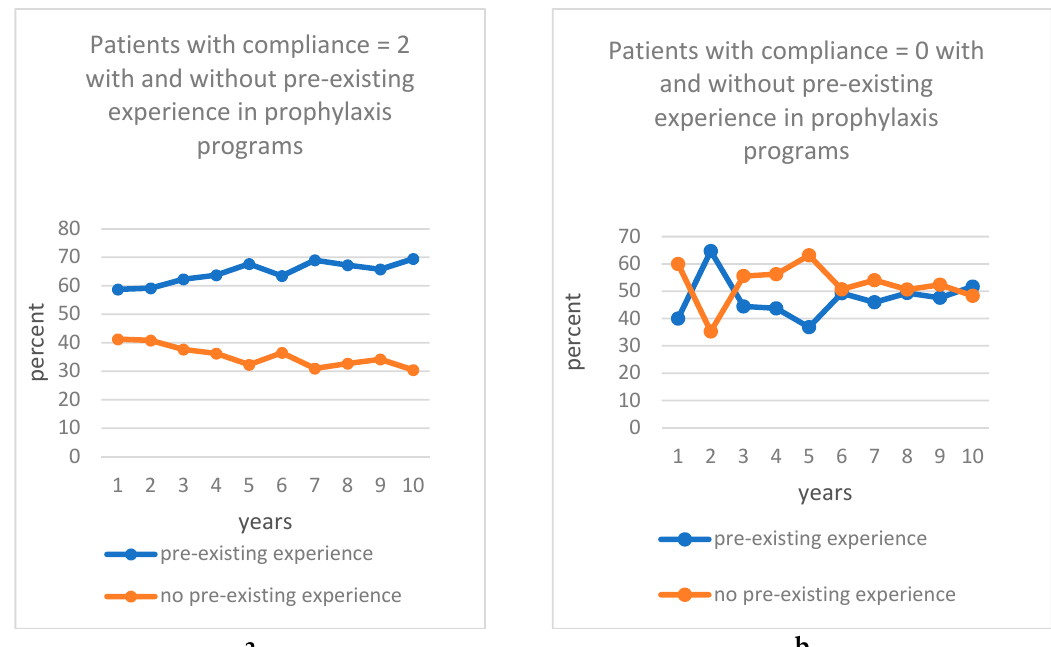
Figure 2. Depiction of the compliance depending on the pre-existing experience in prophylaxis programs; ( a ) Percentage of patients with compliance = 2 with and without pre-existing experience in prophylaxis programs from year 0 to year 10; ( b ) Percentage of patients with compliance = 0 with and without pre-existing experience in prophylaxis programs from year 0 to year 10.